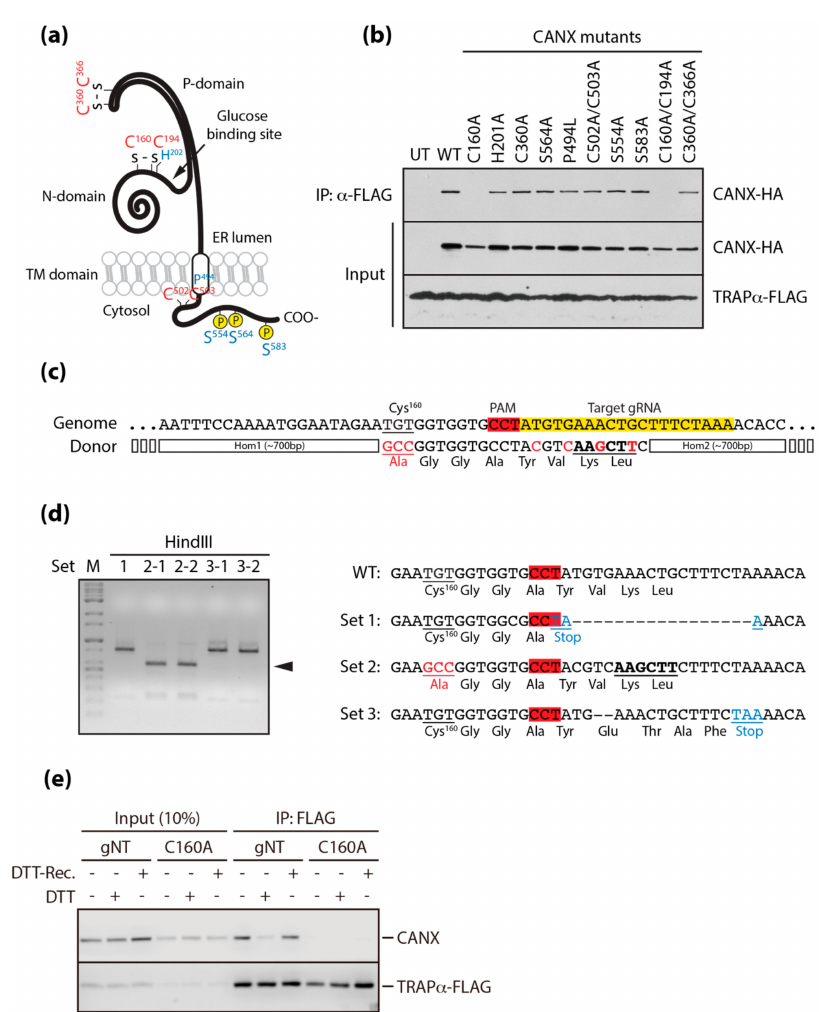
Figure 3. Development of stress-independent PATC. ( a ) Functional residues of the primary sequence of